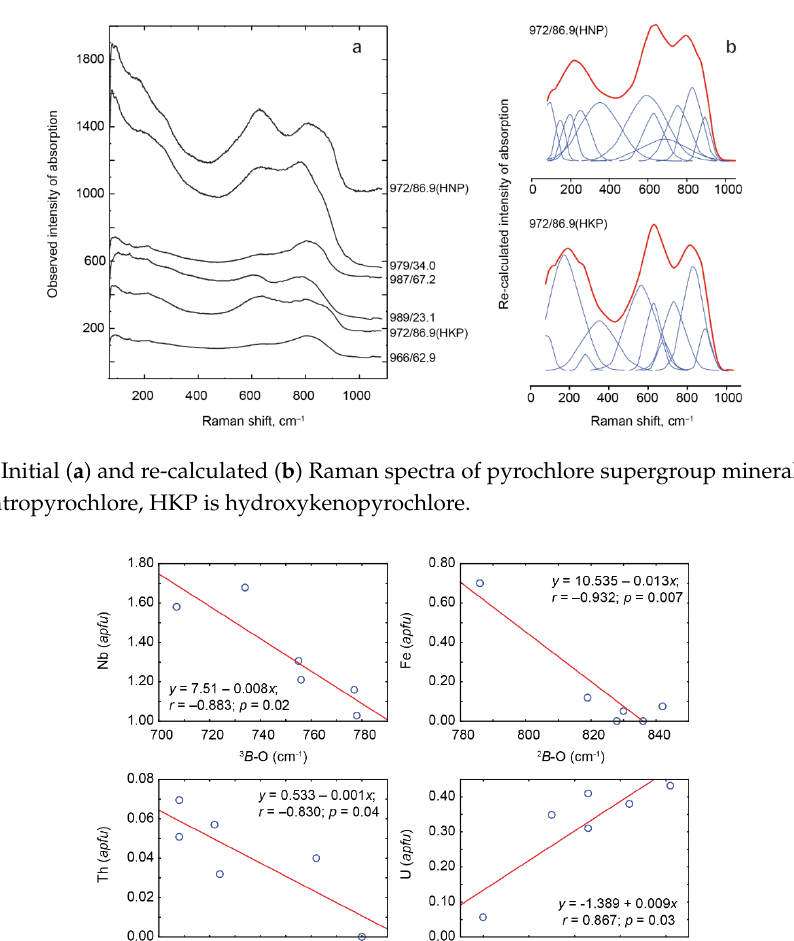
Figure 12. PSM composition vs. position of typical absorption bands in the corresponding Raman spectra.